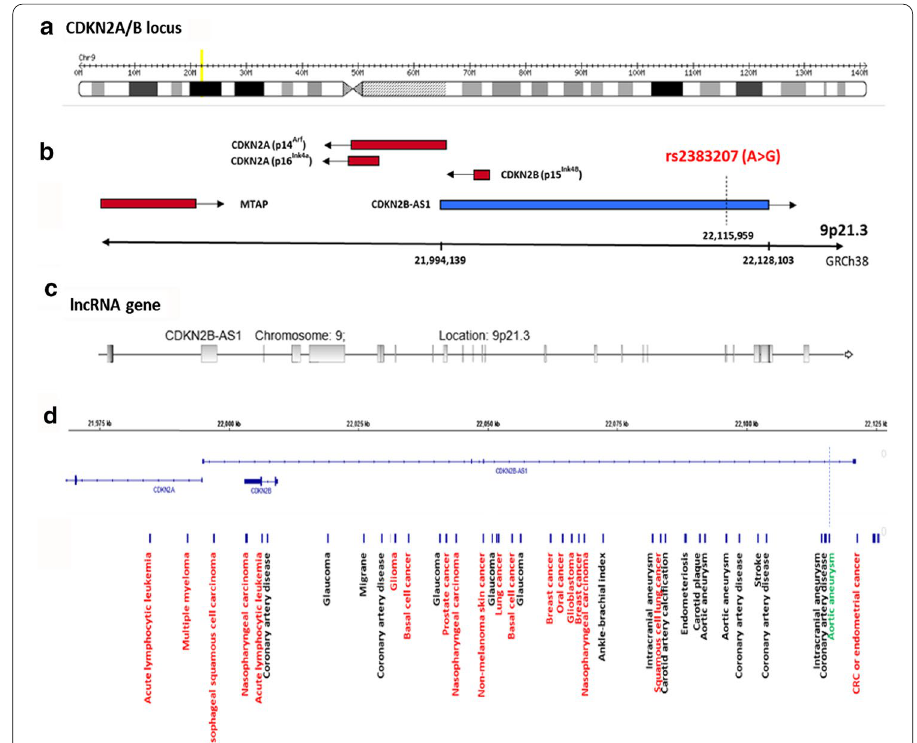
Fig. 1 Genomic structure of CDKN2B-AS1 locus and the common genetic single nucleotide polymorphisms with phenotypic traits. a CDKN2B-AS1 is located at the human CDKN2A/B locus at 9p21.3, and spans a nearly 350 kb genomic region. b It contains three protein-coding genes (red) along with the CDKN2B-AS1 lncRNA (blue). The protein-coding genes include (1) S -methyl-5 ′ -thioadenosine phosphorylase ( MTAP ), (2) CDKN2A that encodes splice variants p16 INK4A and p14 ARF ", and (3) CDKN2B that encodes p15 INK4B ". MTAP lies at one end of the locus, 192 kb telomeric to the 5 ′ start of CDKN2B-AS1 . The selected variant for the present study is shown. ARF alternate reading frame, CDK cyclin-dependent kinase. c At the centromeric end of the locus, CDKN2B-AS1 has a 19–21 exon span over a 126 kb region. CDKN2A lies between CDKN2B- AS1and MTAP. The CDKN2B-AS1 first exon is located 300 bp upstream of ARF in the transcription start site; CDKN2B (two exons) is located within the CDKN2B-AS1 first intron, in an antisense direction. (Data source: http:// ensem bl. org). d The common genetic single nucleotide polymorphisms with phenotypic traits from Genome-Wide Association Studies screening for 9p21.3 locus. Diseases (black) and cancer (red) traits are illustrated. The studied SNP (green) is shown near the end of the CDKN2B-AS1 gene (Data source: http:// igv.